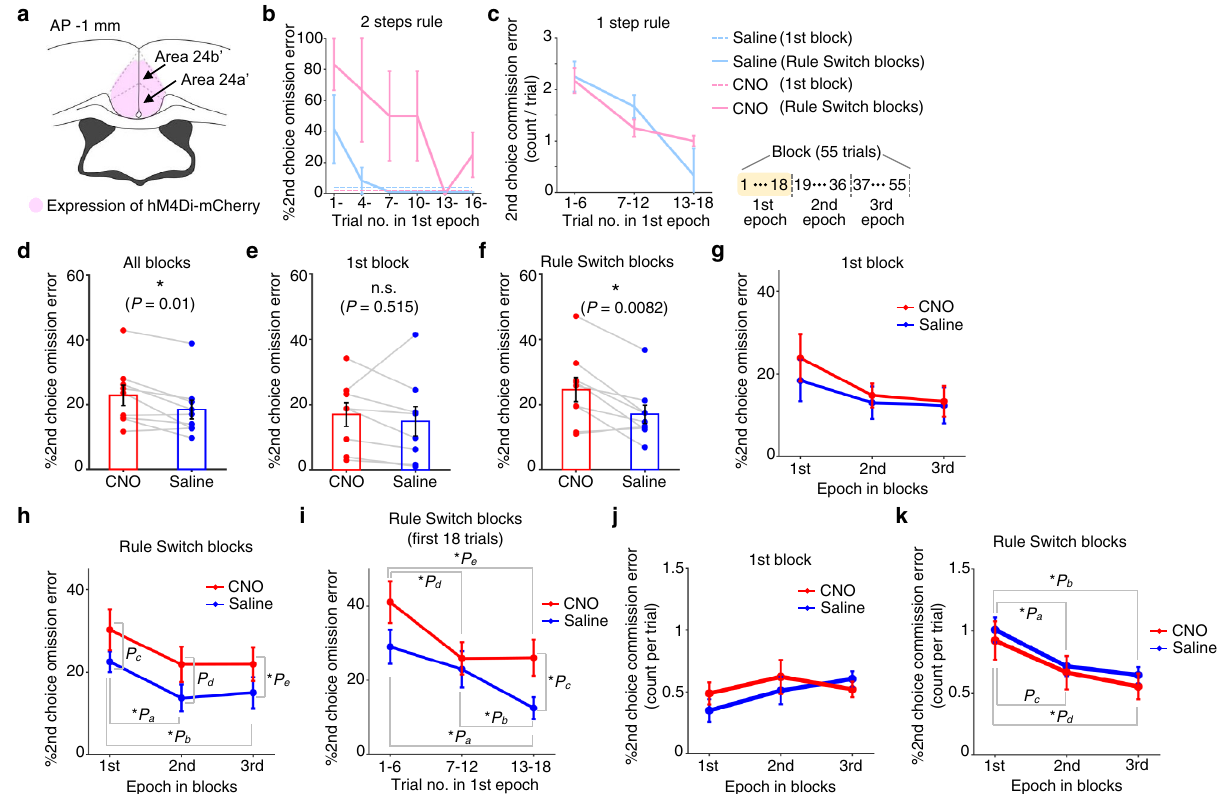
Fig. 2 | Chemogenetic silencing of ACC affected task performance. a Inhibitory DREADD virus was injected in ACC. b 2nd choice performance for 1st epoch in 2 steps condition in representative CNO and saline sessions (three rule switches each for 1 → 2 steps and for opposite direction in both sessions). Blue, saline. Pink, CNO. Dotted and solid lines, 1st and Rule Switch-blocks. c 2nd choice commission error for 1st epoch in 1 step condition for the same sessions. d 2nd choice perfor- manceforall2stepsblocks.Blue,saline.Red,CNO. e Sameasin d ,butfor1stblock. f Sameasin d ,butforRuleSwitch-blocks. g 2ndchoiceperformancefor1stblockin 2 steps condition. Repeated measures ANOVA revealed no main effect ( P >0.4 for dose; P >0.1 for epoch). h Same as in g , but for Rule Switch-blocks. CNO dose showed a main effect ( P =0.018, F 1,50 =5.98 for dose; P =0.051, F 2,50 =3.16 for epoch) with no interaction ( P >0.9). Post hoc comparisons using two-sided